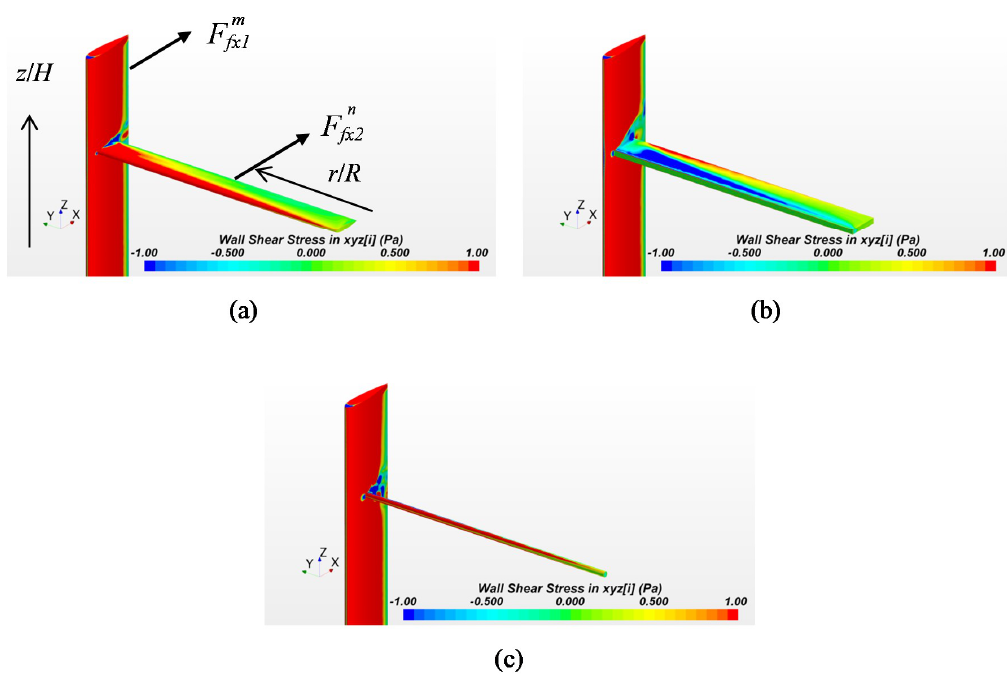
Figure 16. Distributions of x -direction wall shear stress on a blade and an arm in each rotor case with different cross-section arms: ( a ) airfoil arm rotor, ( b ) rectangular arm rotor, and ( c ) circular arm rotor.